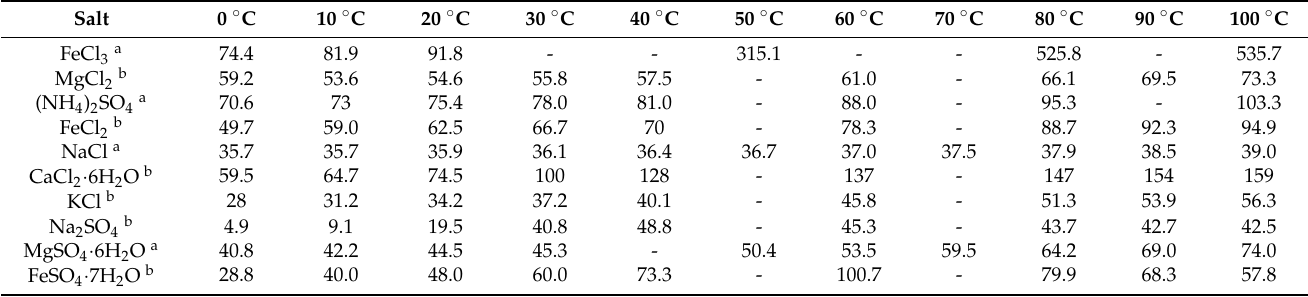
Table 7. Solubility of common inorganic salts in water at various temperatures (g/100 mL